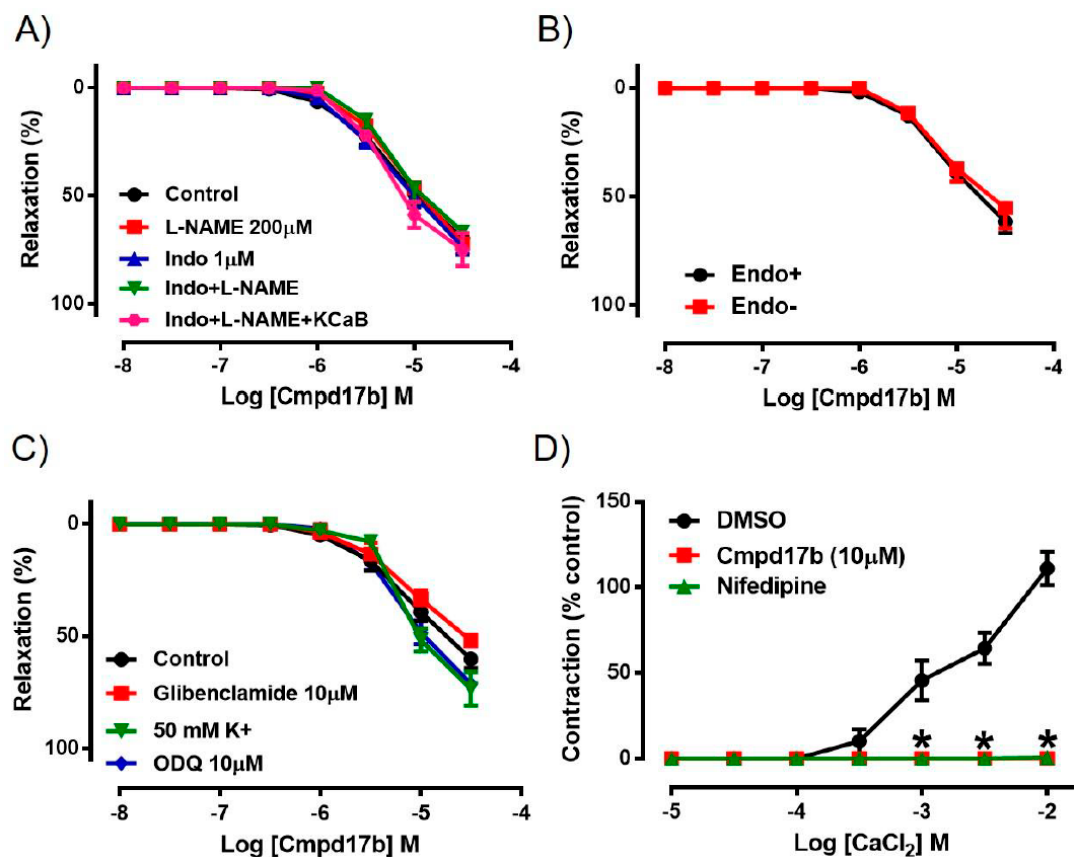
Figure 3. Concentration–response curves to ( A ) Cmpd17b in the presence of DMSO (control), L-NAME (NOS inhibitor), Indo (non-selective COX inhibitor), L-NAME + Indo, or LNAME + Indo + KCaB (inhibitors of K Ca 3.1 and K Ca 2.x channels) in the aorta of male mice. Concentration–response curves to Cmpd17b in ( B ) endothelium intact and endothelium denuded aorta or ( C ) in the presence of 50mM K + , ODQ (soluble guanylate cyclase inhibitor) or glibenclamide (ATP-sensitive potassium channel blocker). Concentration–response curves to ( D ) CaCl 2 in aorta treated with control (DMSO), Cmpd17b, or nifedipine (calcium channel blocker). * P < 0.05, significantly different to control. Values are expressed as mean ± SEM, n = 3–12 per group. Sensitivity (pEC 50 ), maximum relaxation (R max ), and maximum constriction (E max ) values are shown in Table 1.